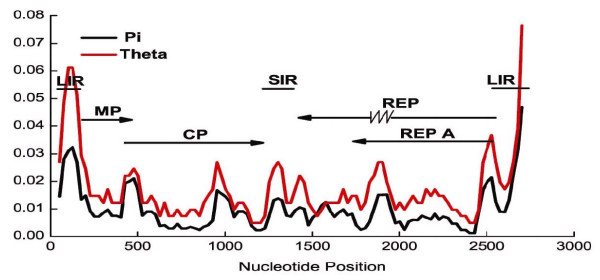
Distribution of genetic diversity across the WDV genome based on 29 Chinese WDV isolates. Values of Watterson's theta and of the Pi (π) estimate of the average pairwise differences between sequences in a sample were determined for windows of 100 residues evaluated every 25 residues. Diagrammed are positions of the large (LIR) and small (SIR) intergenic regions and the MP, CP, Rep and Rep A coding regions. The zig-zag line in Rep identifies the intronic region of the gene.